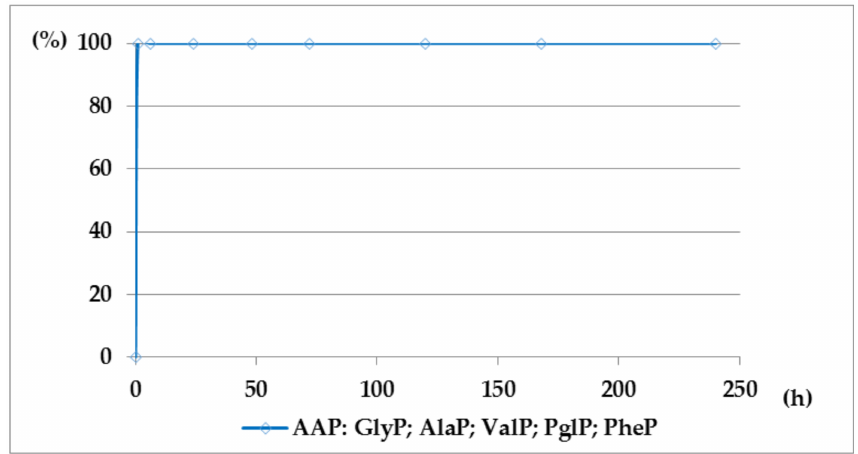
Figure 5. A solution of 0.1 M 1-(trifluoroacetylamino)alkylphosphonic acids TFA-AA P in 2 M KOH reacted at 25 ◦ C, which was monitored by 31 P NMR [DD (%) vs. time